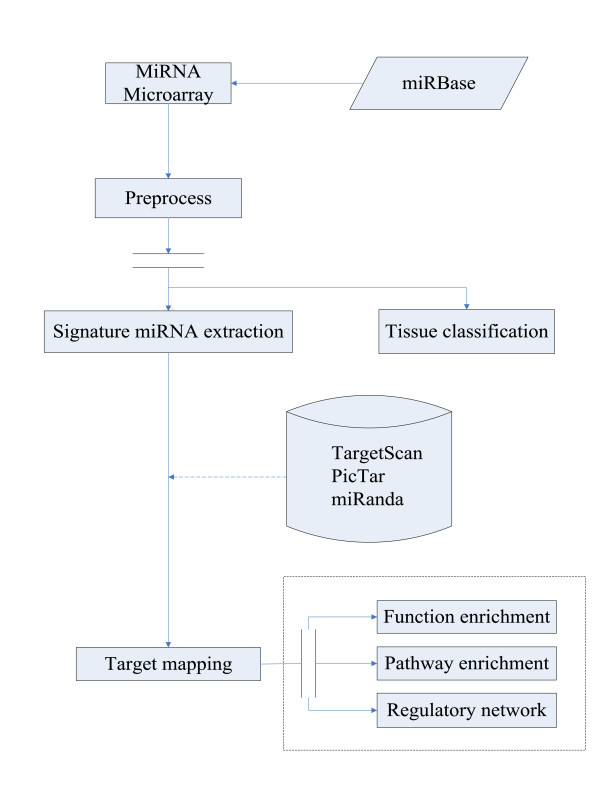
The overall procedure. The overall procedure of neural tissue-specific miRNA identification and functional analysis of targets was composed of four parts: obtaining miRNA expression profiles of 14 rat tissues, classification of tissues, extraction of signature miRNAs, and target mapping.